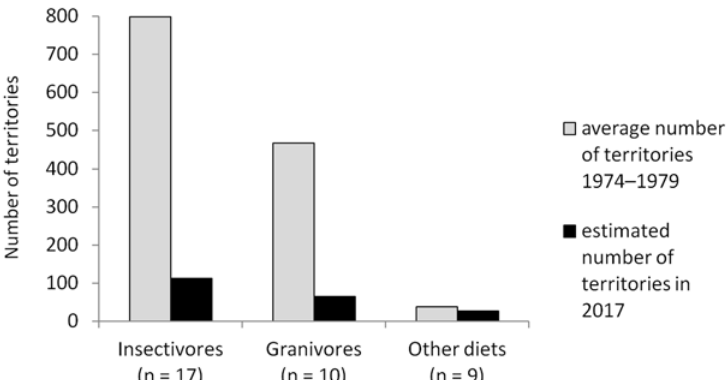
Figure 5. Number of territories across species for breeding birds of open cultivated landscapes at “Lampertheimer Altrhein” between 1974 and 1979 (average values) and in 2017 grouped by main diet. The category "Other diets" includes vertebrate consumers and omnivores. The values for 2017 were extrapolated to the size of the study area in 1974–1979.